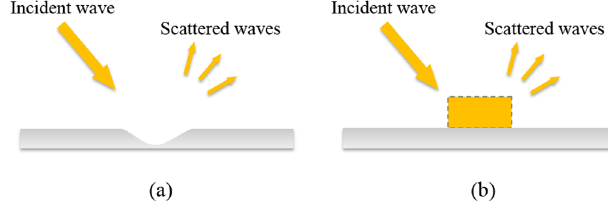
Fig. 1. Groove illusion. (a) Scattered waves by a groove to be mimicked. (b) Scattered waves by an illusion medium on a fl at surface.